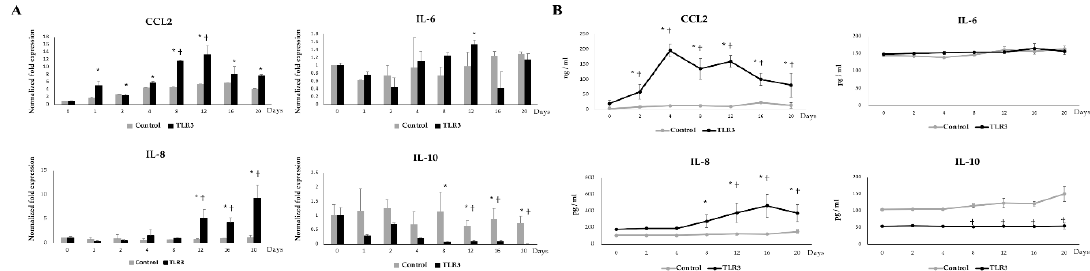
Figure 10. TLR3 mediated adipokine production in adipocytes. The mRNA expressions ( A ) and protein concentration ( B ) of CCL2, IL-6, IL-8, IL-10 in the adipocytes at different time points of 20 days of differentiation. Data shown are the mean ±SD of 3 independent experiments performed in triplicates. The ‘*’ indicated statistical differences when compared with day 0, and ‘†’ indicated statistical differences when compared with the control group at the same time point, both at the significance level of p < 0.05.